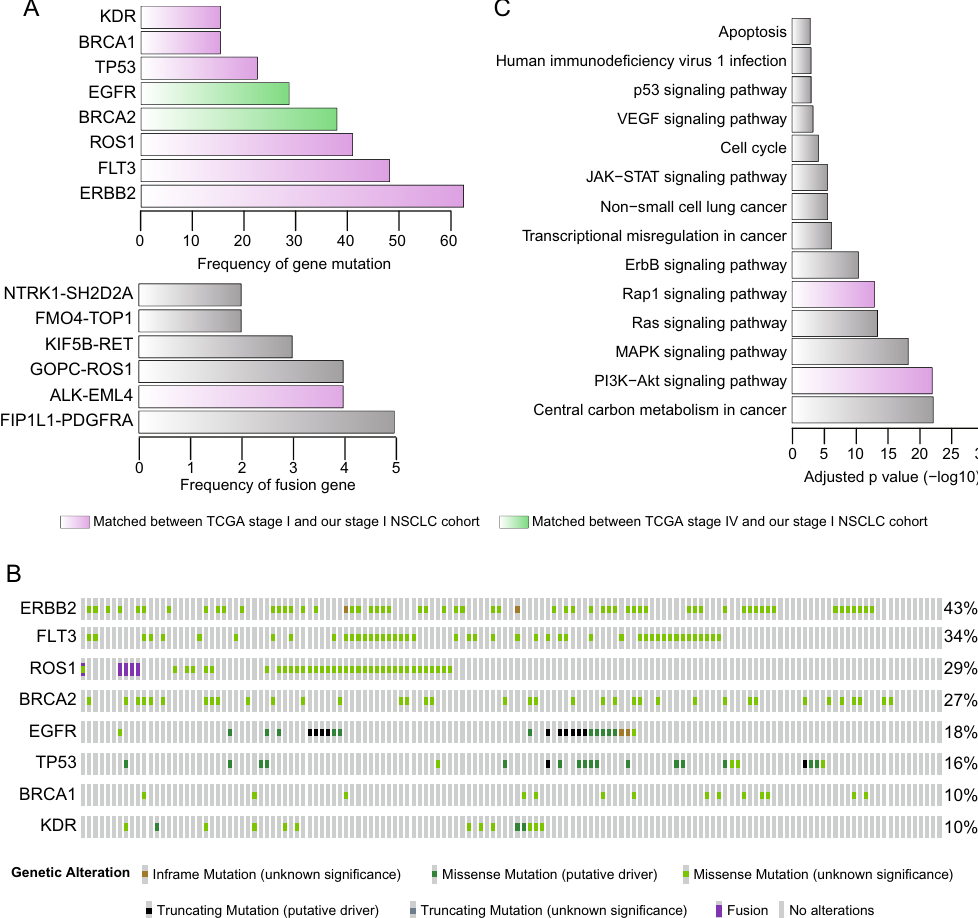
Figure 2. Landscape of gene mutations and fusions. ( A ) The landscape of gene mutations (top) and fusions (bottom) is shown by a bar plot according to their occurrence frequency. Gene mutations with frequencies over 10% and fusion genes with frequencies over two are shown. ( B ) The detailed landscape of gene mutations was described by the OncoPrinter tool 35 . The bars colored gray, purple, and green indicate genes for which variants were reported in none, stage I, and stage IV of the TCGA cohort, respectively. ( C ) Functional enrichment in biological pathways analyzed by EnrichR 30 . The letters colored gray, purple, and green indicate pathways that were enriched in none, stage I, and stage IV of the TCGA cohort,